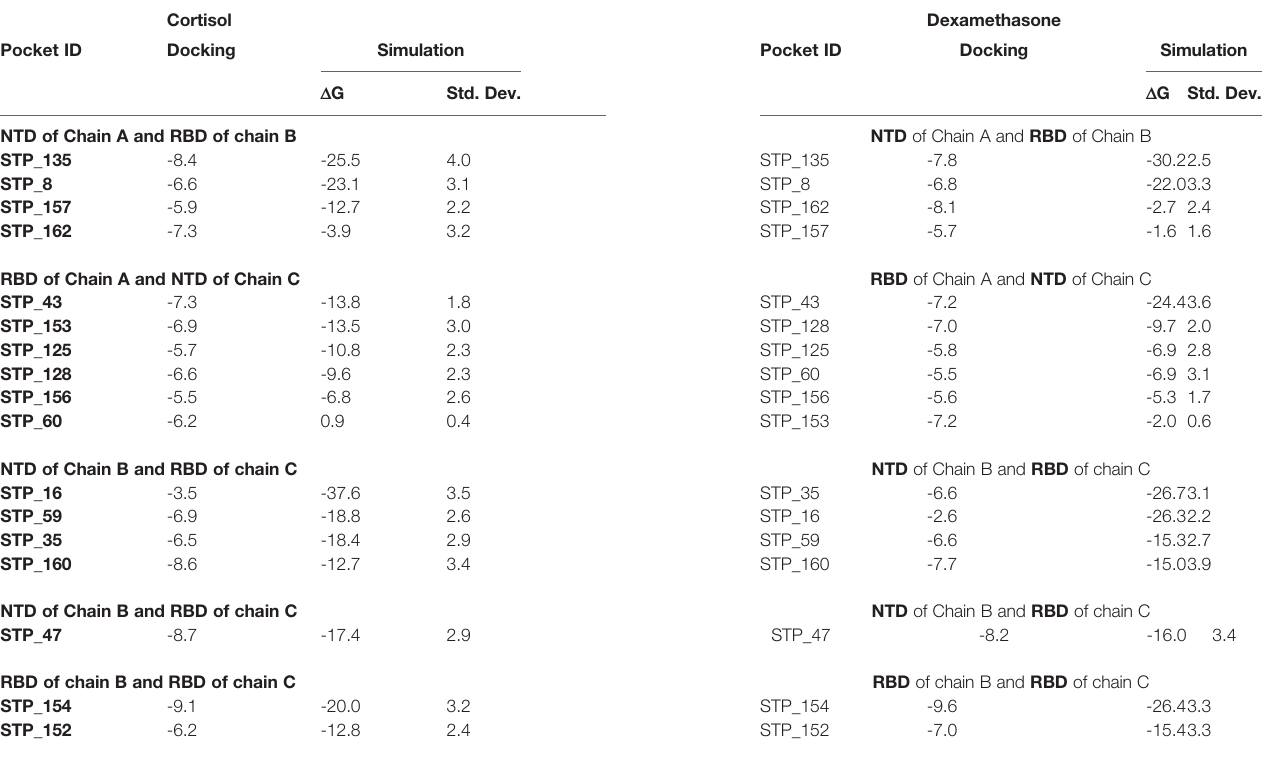
TABLE 4 | Binding energies of cortisol and dexamethasone for each S1 pocket at the interfaces after docking and MD. Cortisol Pocket ID Docking